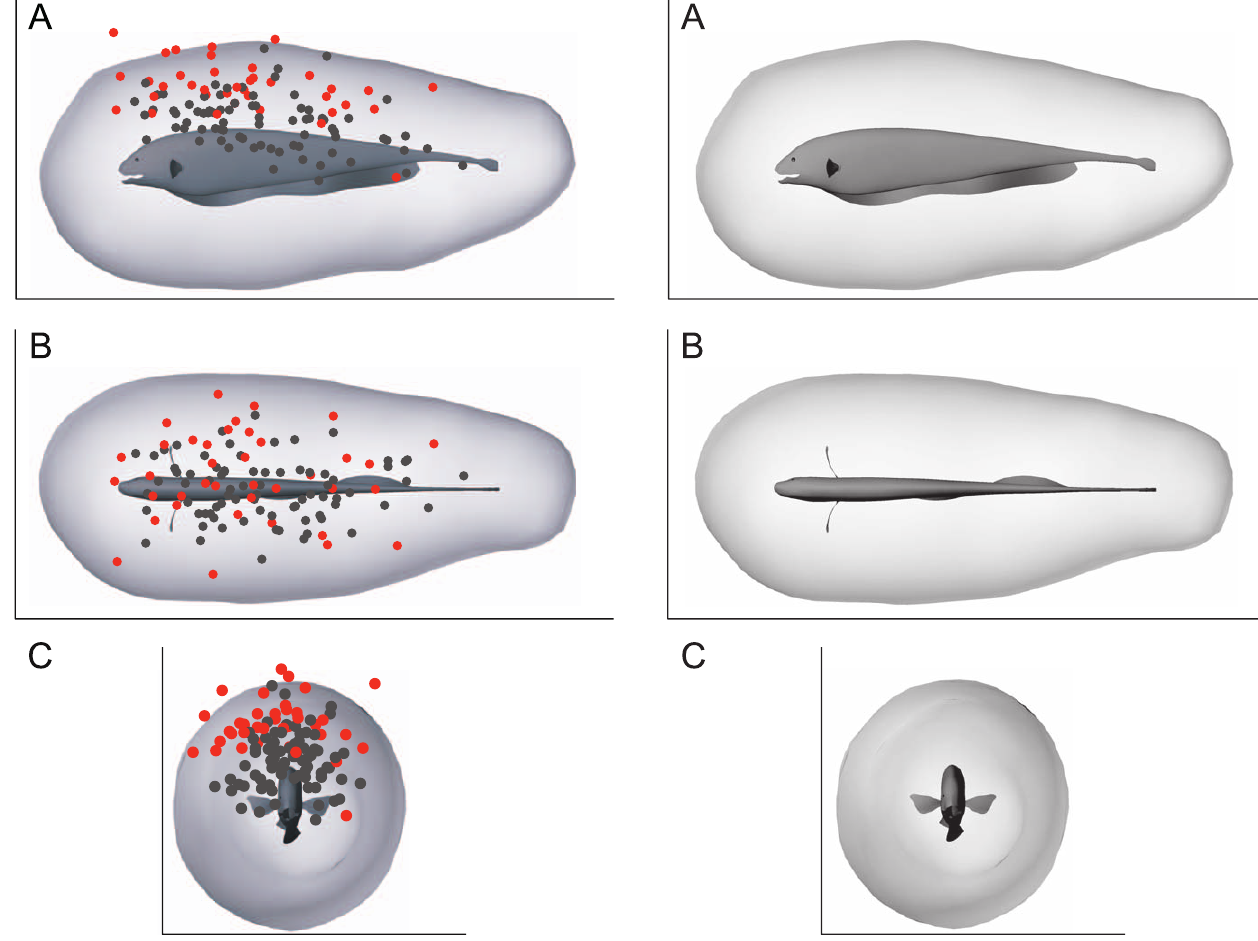
Figure 2. Computed Sensory Volume Overlaid with Measured Detection Locations (A) Side view. (B) Top view. (C) Front view. Dots indicate positions of water fleas ( D. magna ) at the time of detection (in body-fixed coordinates), based on earlier behavioral results [11]. Detections occurring at water conductivities of 100, 300, and 600 l S/cm are shown as black dots ( N ¼ 78), whereas detections at 35 l S/cm are shown as red dots ( N ¼ 38). The dorsal bias of empirically measured detection points arises from a combination of the search strategy used by the fish and the fact that prey were introduced into the tank from above